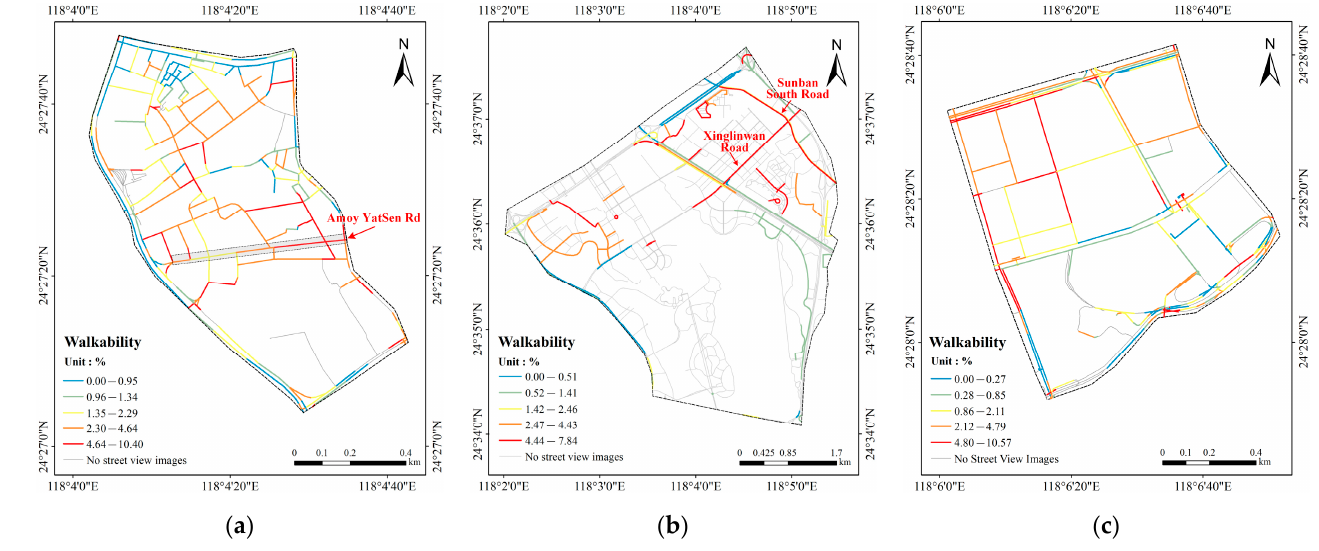
Figure 10. Visualisation results of walkability in ( a ) Area Ⅰ , ( b ) Area Ⅱ , and ( c ) Area Ⅲ . Moreover, the distribution of walkability and motorization is inversely related, as shown in Figures 10 and 11. Streets with higher motorization have greater interference to sidewalks, and it may not be conducive to walking activities, so the street has lower walkability and fewer